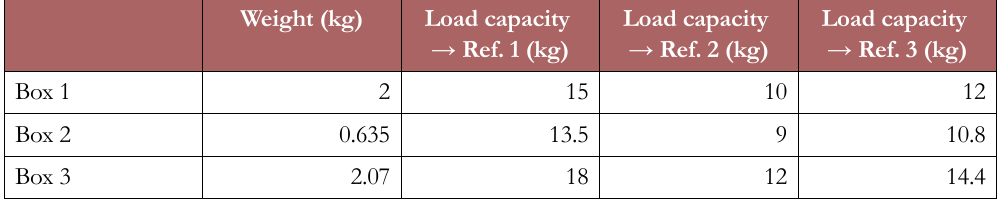
Table 1. Packaging